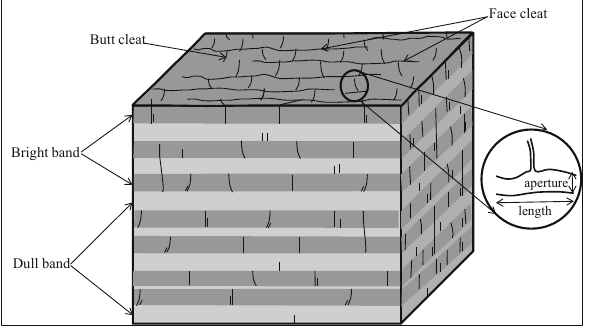
Fig. 1 Schematic diagram of bright bands, dull bands, face cleats and butt cleats (figure not to scale) in a typical banded coal sample (modified after Laubach et al. 1998). The figure contains ‘primary’, ‘secondary’, ‘tertiary’ and ‘master cleats’. In this analysis, the length, spacing, and apertures are measured from all of these cleat